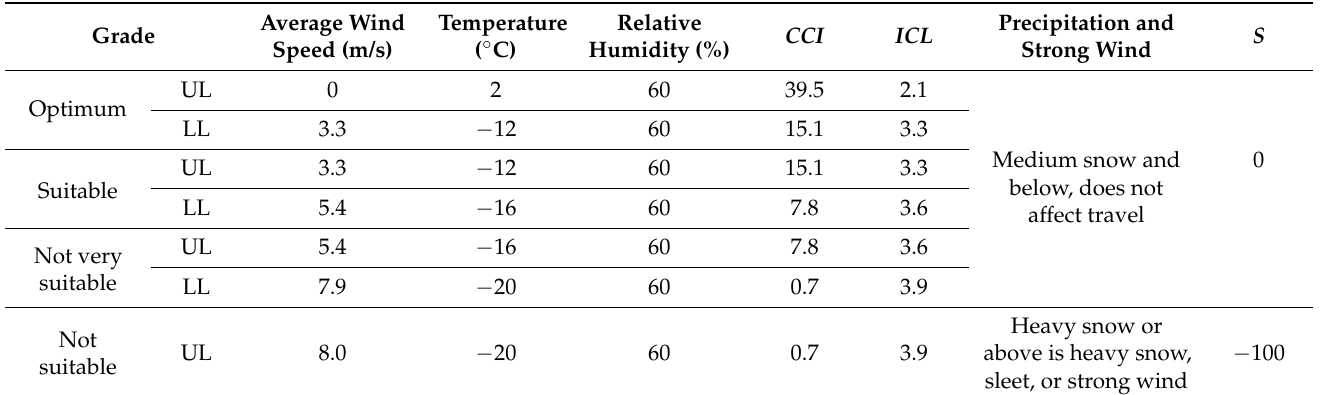
Table 3. Grading standard of ice–snow tourism suitability index ( ISTSI ) evaluation model.